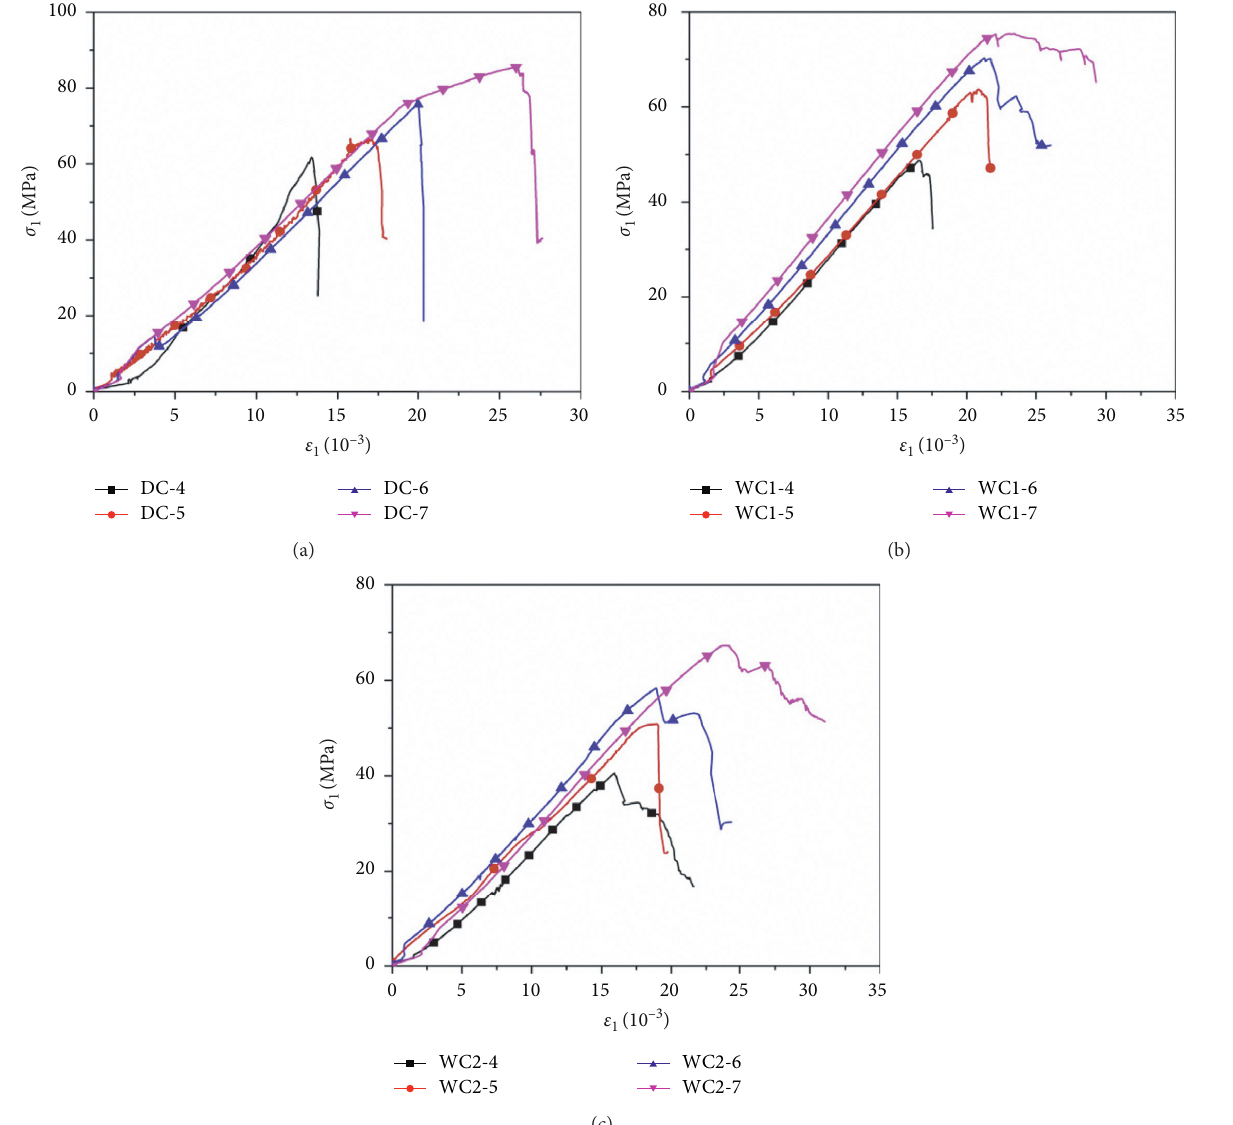
Figure 7: Stress-strain curves of the coal specimens under triaxial compression: (a) DC group, (b) WC1 group, and (c) WC2